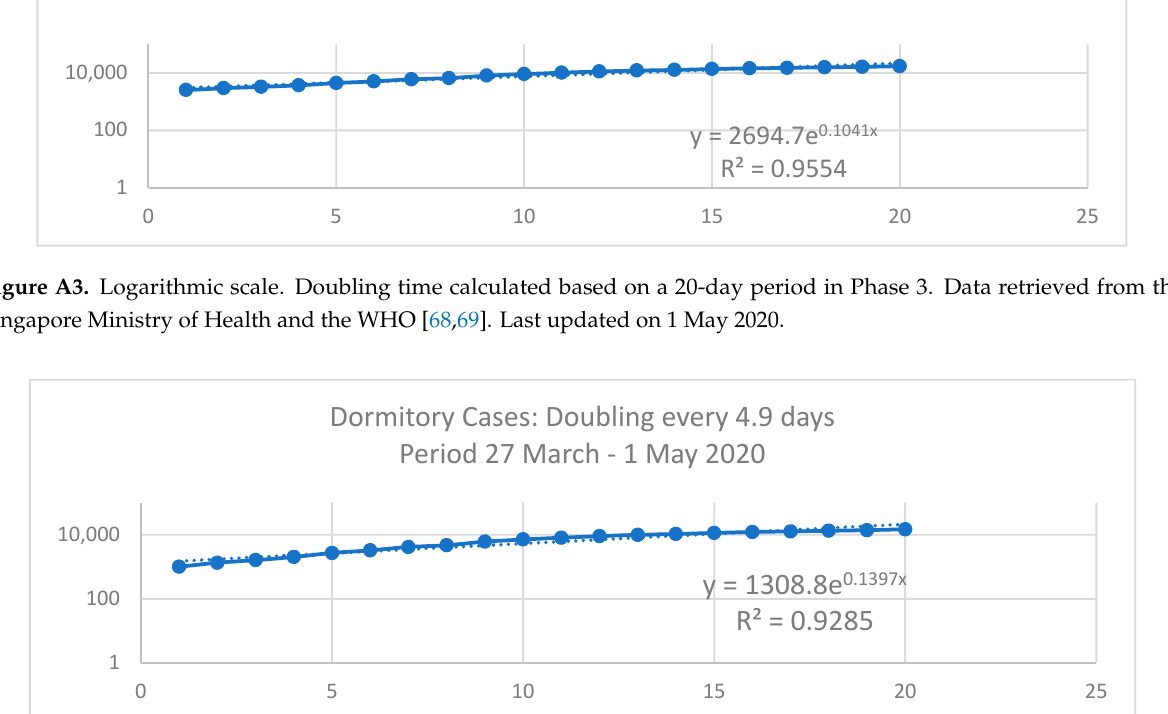
Figure A4. Logarithmic scale. Doubling time of conformed Dormitory cases in Singapore. Data retrieved from the Singa-